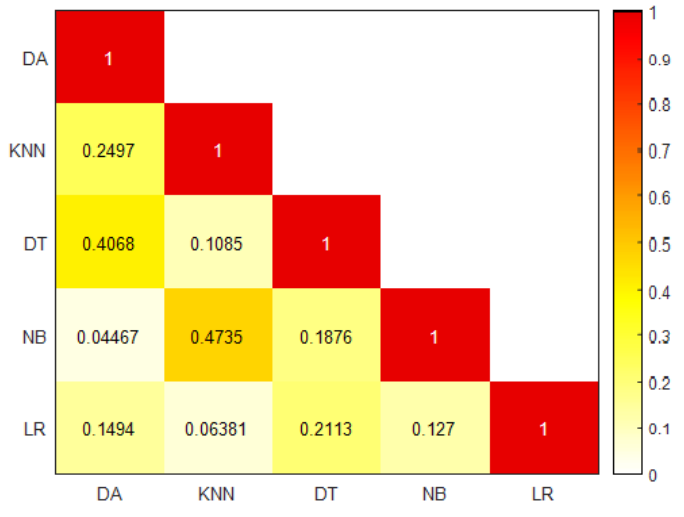
Figure 3. The Spearman correlation coefficient results .